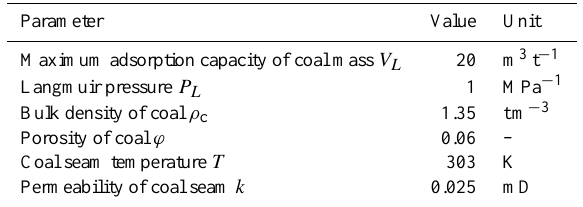
Figure 3. Annular low-permeability zone in coal seam.